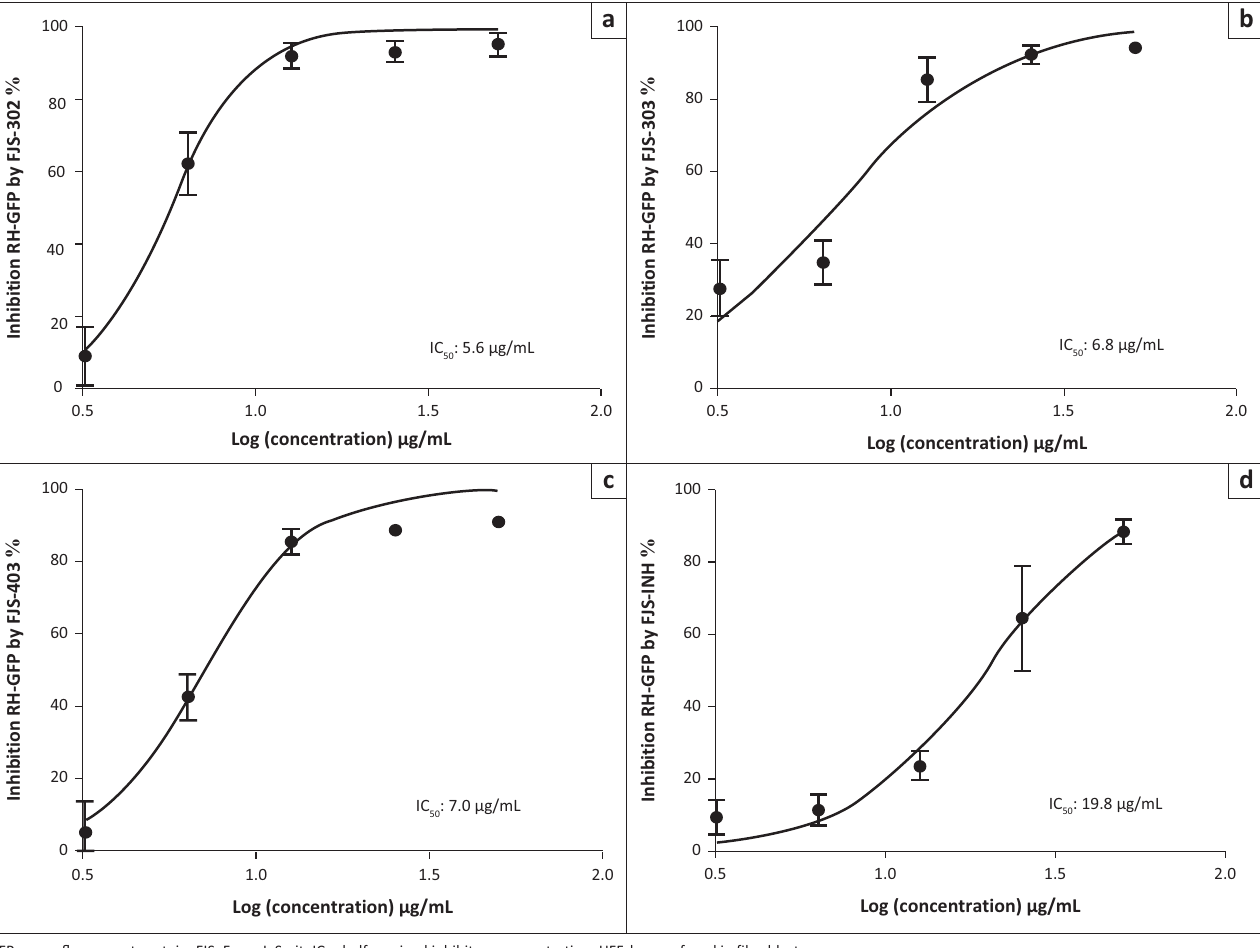
FIGURE 2: The IC values of (a) FJS-302, (b) FJS-303, (c) FJS-403 and (d) FJS-INH on Toxoplasma gondii RH-GFP. The RH-GFP-infected HFF cells were treated with the 50 given chemical compounds for 72 h at different concentrations from 3.125 µ g/mL to 50 µg/mL. Data represent the mean values ± s.d. of three independent